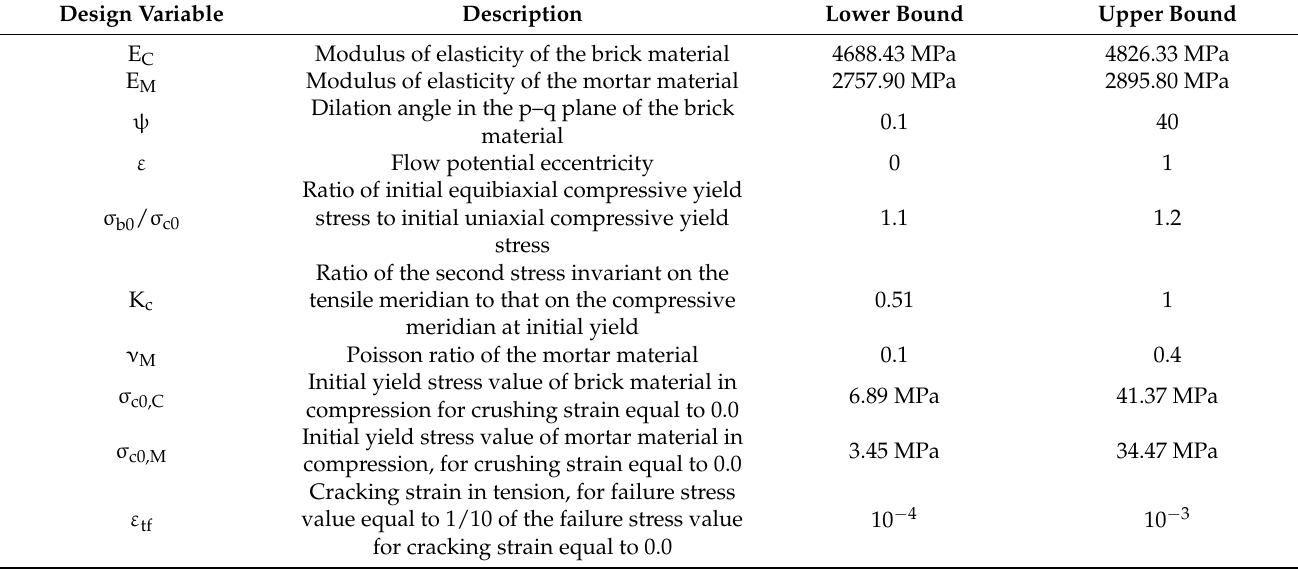
Table 1. Description and bounds of the design variables considered for fitting the experimental stress strain curve of the